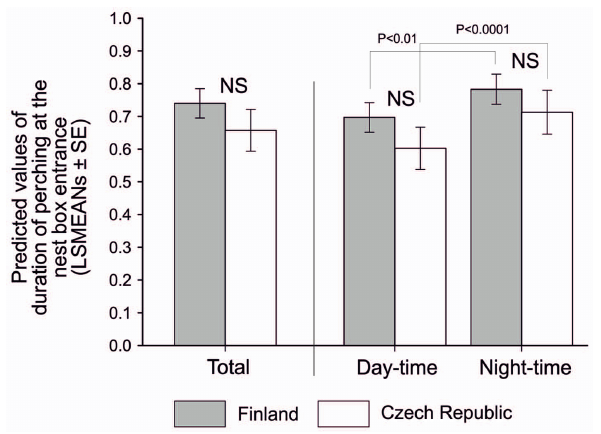
Figure 1. Comparison of log-transformed individual duration of nestlings’ perching at the nest box entrance between and within the two study sites (Finland and Czech Republic) and parts of the day: Total (pooled day-time and night-time data), Day-time data, and Night-time data (LSMEANs 6 SE).